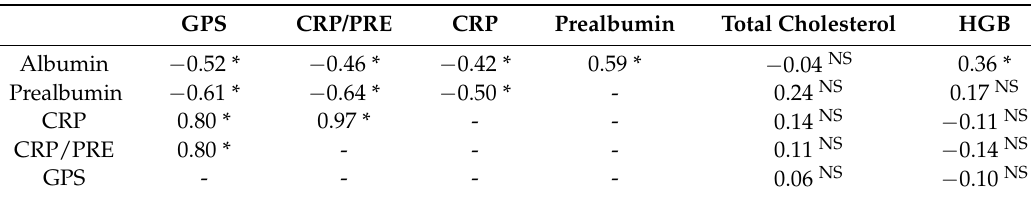
Table 3. The correlations between the selected markers of malnutrition and inflammation, as well as total cholesterol, and hemoglobin (HGB).